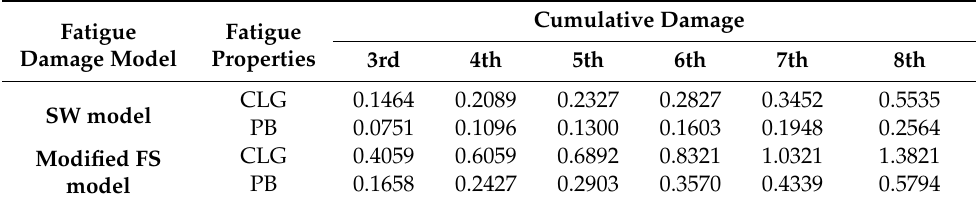
Table 7. Comparison of fatigue damage models using fatigue properties of structural details for